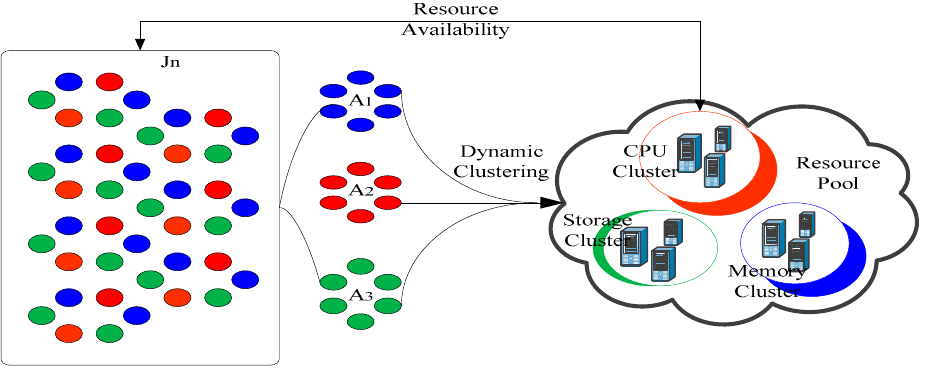
Figure 3. Dynamic